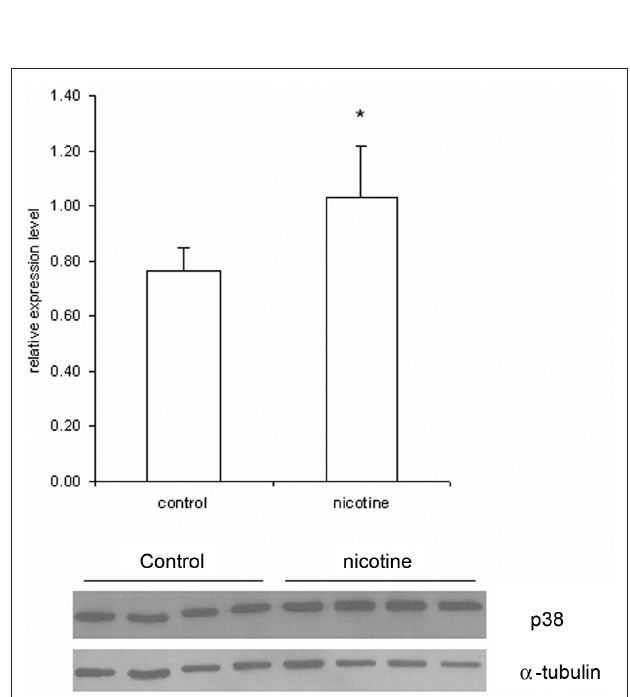
Figure 4 | expression of MAPK14 (p38 MAPK) protein in SH-SY5Y cells determined by Western blotting. The SH-SY5Y cells were treated for 1 h with or without (Controls) 1 mM nicotine. After treatment, protein was purified from the lysates and analyzed by Western blotting. In this figure, the MAPK14 concentration was determined using a specific monoclonal antibody. The histogram shows the relative expression of MAPK14 normalized to expression of α -tubulin, which demonstrated that the protein concentrations in nicotine-treated cells are significant higher than those in controls ( p < 0.03). Data are presented as mean ± SEM ( N =